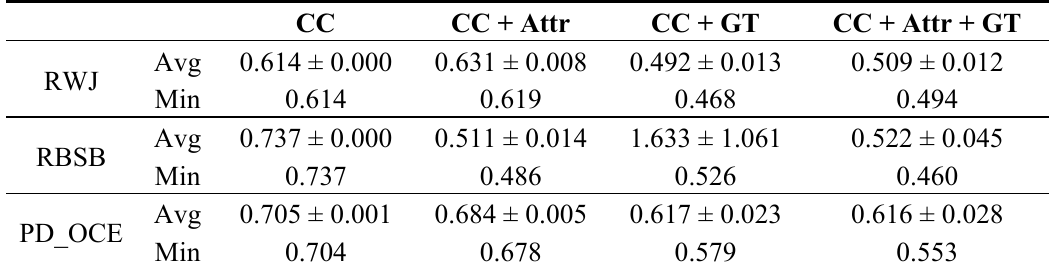
Table 10. Method performances on the Hagadera problem. The top performing method variant is metric